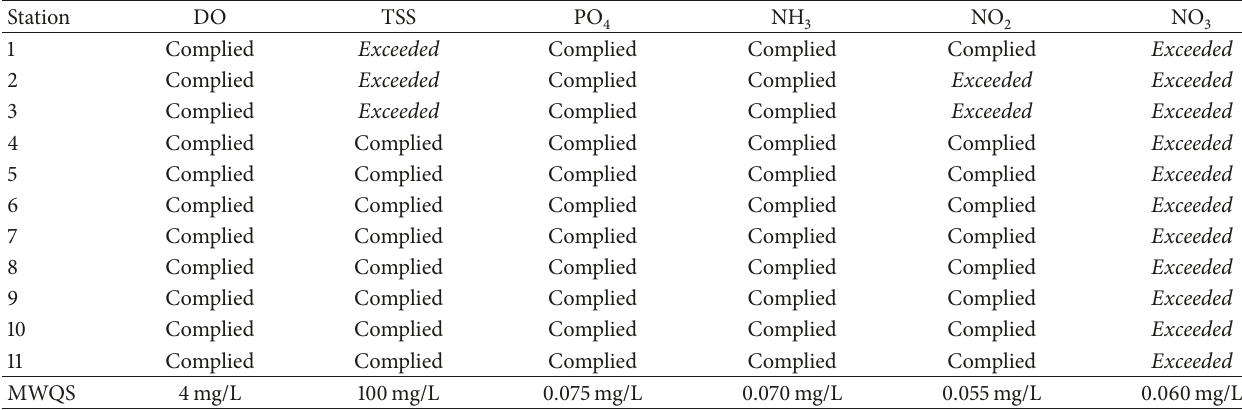
Table 1: Sarawak coastal water quality standard according to the Malaysia Marine Water Quality Criteria and Standard (MWQS) [27].